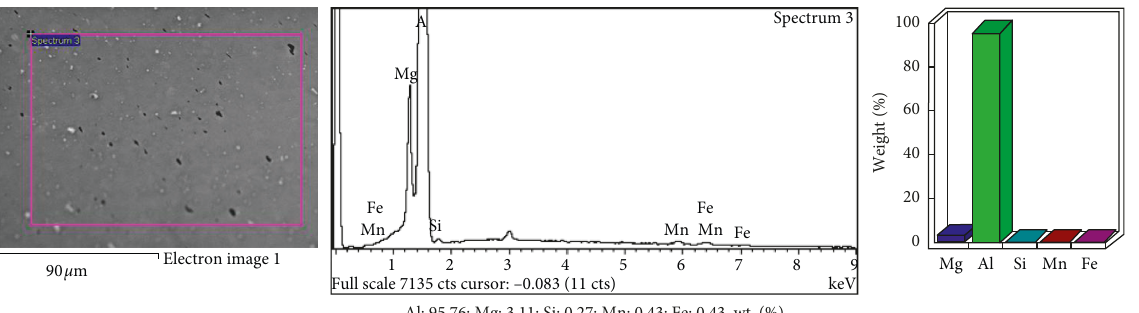
Figure 6: Example of EDS analysis at SZ of sample welded at 140mm/min. (a) Scanned area; (b) element histogram; (c) quantitative EDS results.